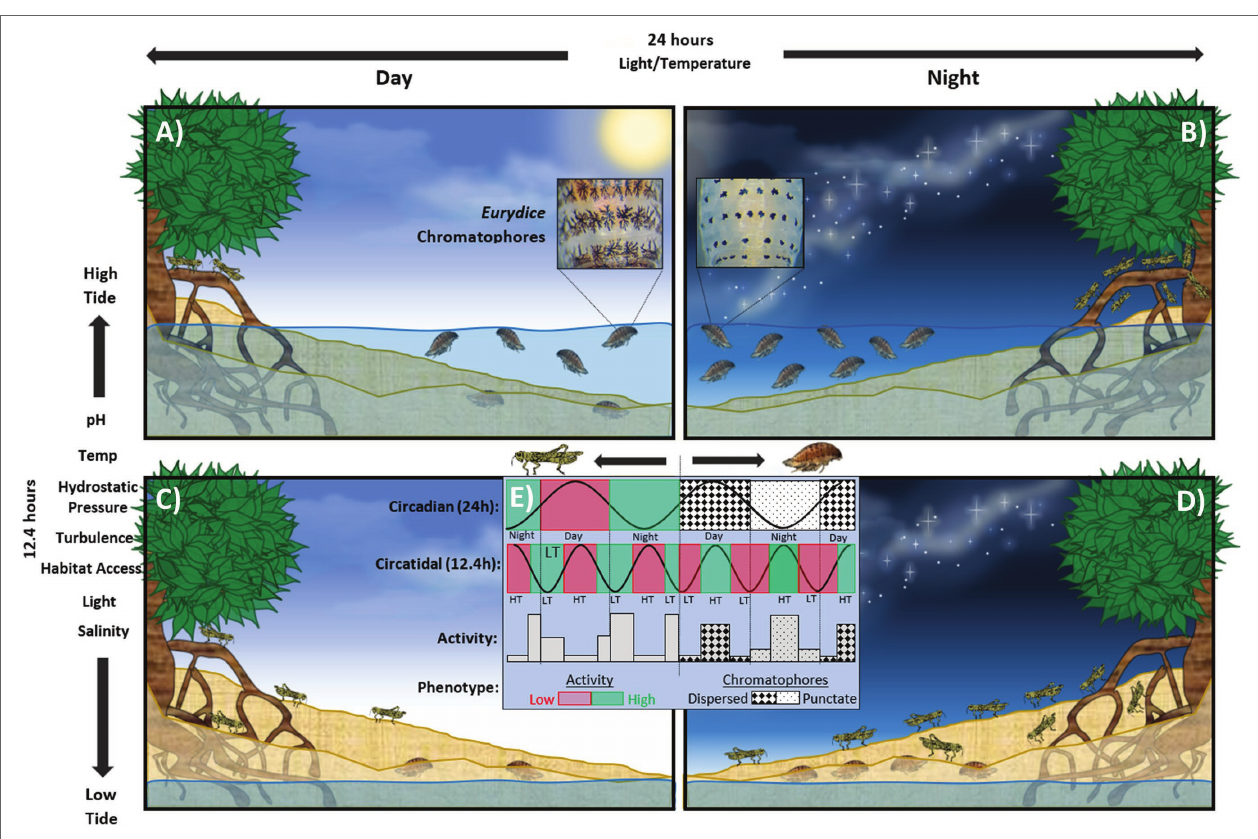
FIGURE 1 | Representation of clocks of the speckled sea louse, Eurydice pulchra and the mangrove cricket Apteronemobius asahinai on a hypothetical shore. (A) Diurnal high tide; Eurydice appears more pigmented (circadian behaviour) and is active in the water column (circatidal behaviour). Apteronemobius is active (circadian) but does not forage (circatidal). (B) Nocturnal high tide; Eurydice appears less pigmented but is very active in the water column. Apteronemobius is not active. (C) Diurnal low tide; Eurydice appears pigmented but is buried in the sand. Apteronemobius is actively foraging on the shore. (D) Nocturnal low tide; Eurydice appears less pigmented and is buried. Apteronemobius is active but does not forage. (E) Summary of phenotypes as they relate to the circadian and circatidal cycles. Principle environmental zeitgebers for circatidal and circadian rhythms shown to the left and above panels,